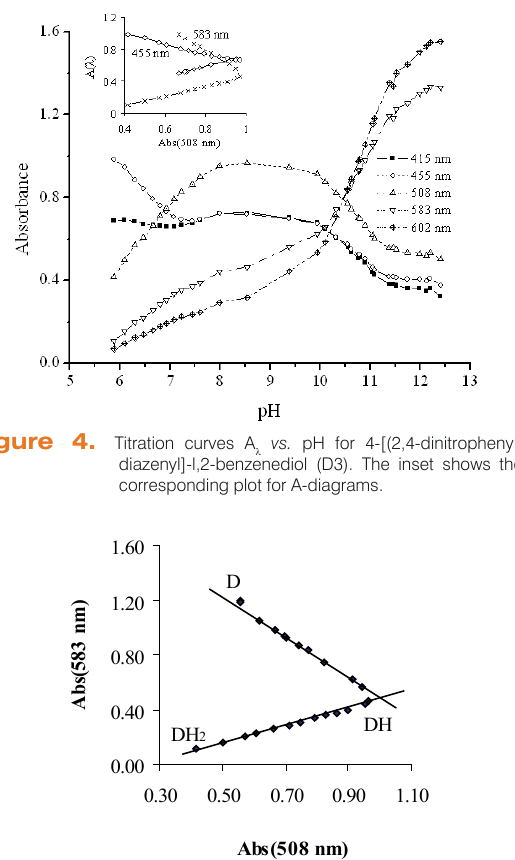
-A )×10 -pH λ λ (DH) of D3 λ